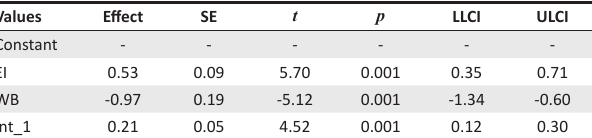
TABLE 4: Interactive effect between workplace bullying and emotional intelligence in predicting flourishing (model).